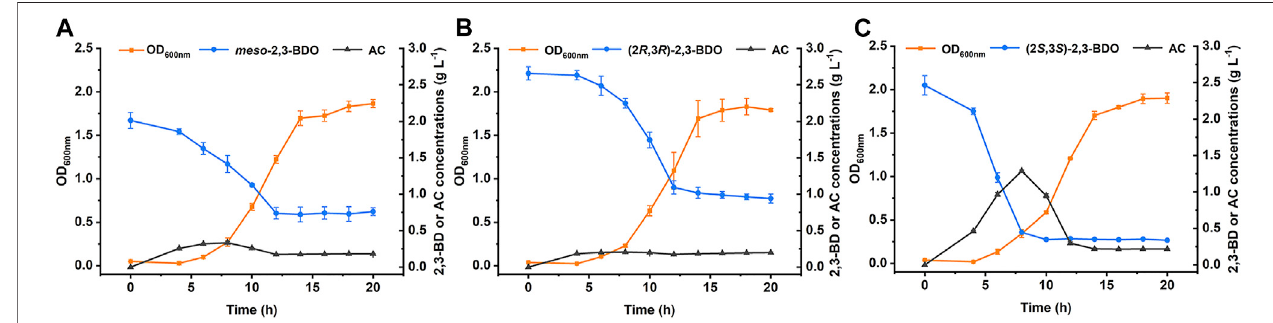
FIGURE 1 | Growth of P. putida KT2440 in three stereoisomers of 2,3-BDO. The biomass, 2,3-BDO consumption, and AC production were measured in MSM supplemented with 2 g L − 1 different stereoisomers of 2,3-BDO as the sole carbon source. (A) meso -2,3-BDO. (B) (2 R ,3 R )-2,3-BDO. (C) (2 S ,3 S )-2,3-BDO. Error bars indicate deviation from the means ( n (cid:2) 3).